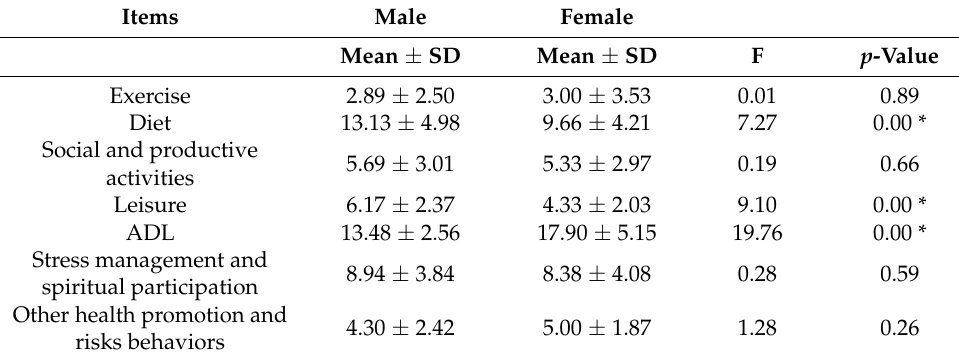
Table 3. Lifestyle differences between the sexes (N = 60).